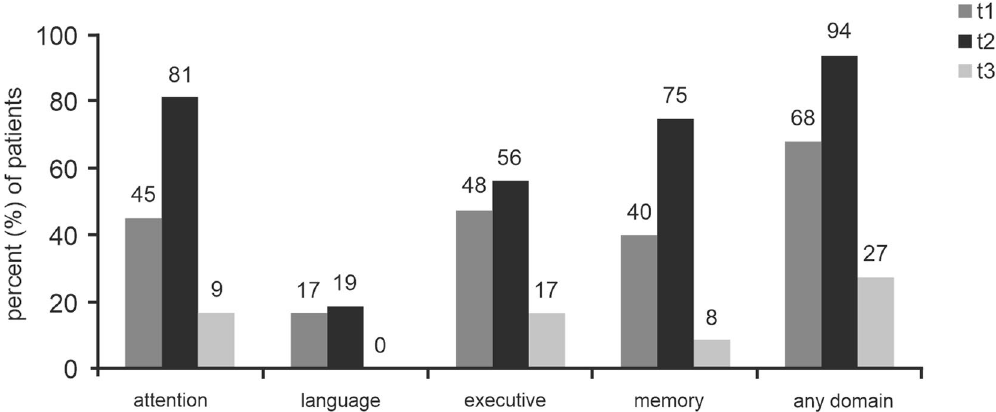
Figure 3. Domains, for which normative data were available. Percentage of patients impaired per domain, considered as a decrease in a Z-score of more than 1.5 SD, at time points t1 (prior to surgery), t2 (before hospital discharge) and t3 (at long-term